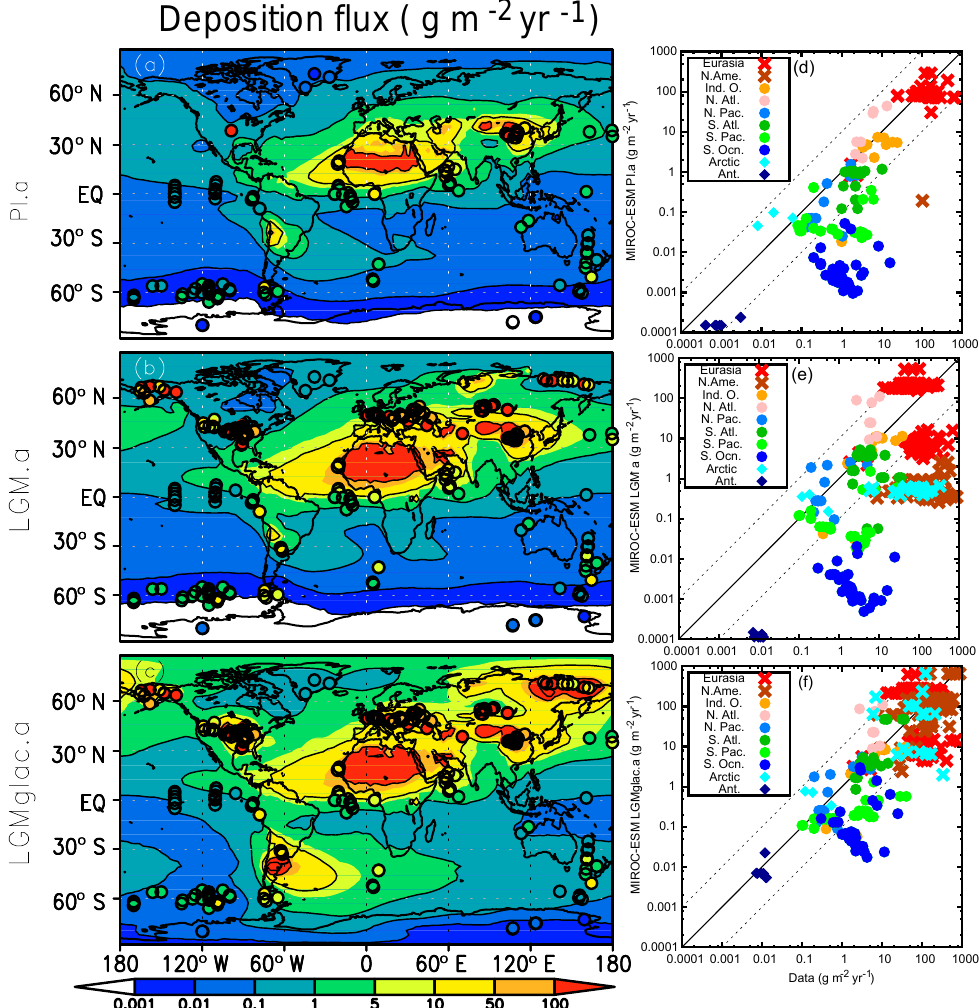
Figure 4. Model–data comparison of dust deposition flux (gm − 2 yr − 1 ) estimated from the ice and sediment core data archives obtained from Kohfeld et al. (2013) and bulk data from Albani et al. (2014): (a) PI.a, (b) LGM.a, and (c) LGMglaca. Model–data scatter plots for (d) PI.a, (e) LGM.a, and (f) LGMglaca. Colours and marks represent areas and core types, i.e. red: Eurasia, brown: North America, orange: Indian Ocean, pink and light blue: Atlantic and Pacific oceans in the Northern Hemisphere, respectively, green and light green: Atlantic and Pacific oceans in the Southern Hemisphere, respectively, blue: Southern Ocean, turquoise blue: Arctic, and dark blue: Antarctica. Crosses, circles, and diamonds represent terrestrial, marine core, and ice core sediments,